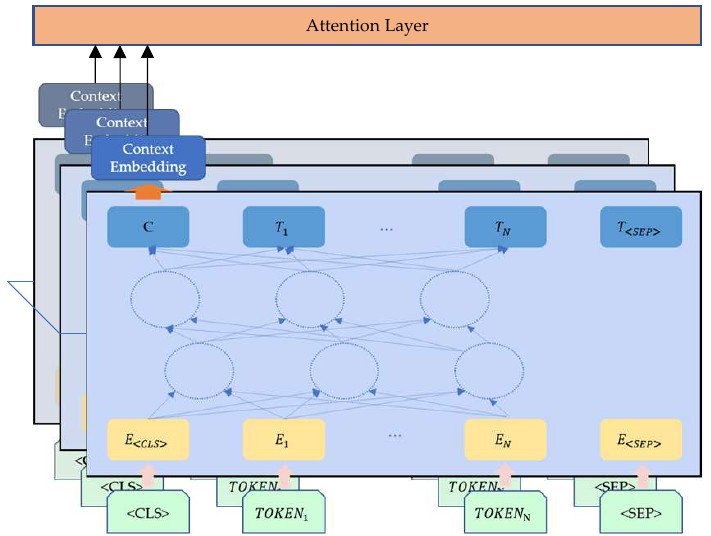
Figure 3. Attentive news